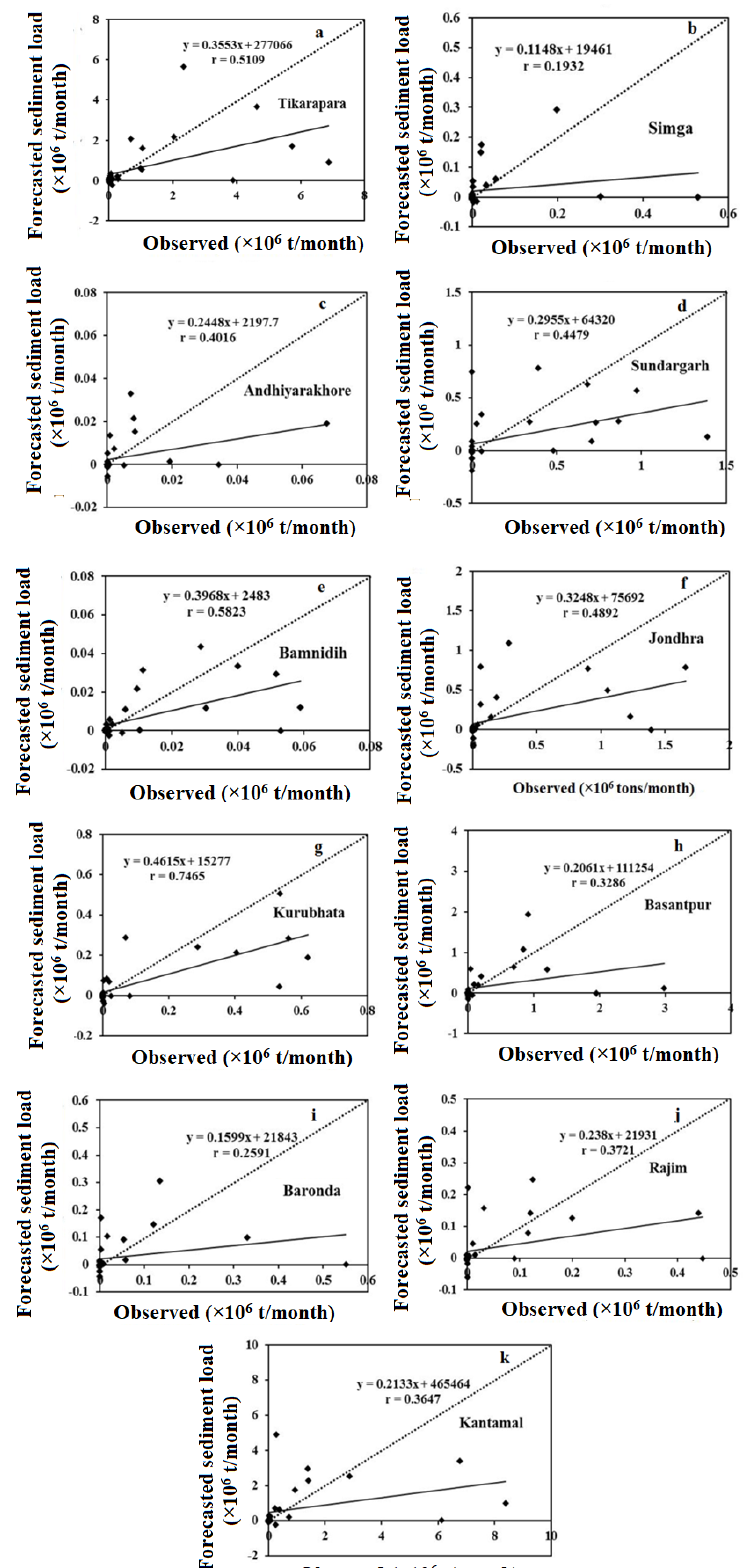
Figure 10. Scatter plot of the actual and forecasted SL of the AR forecasting model during the testing phase (a-k).